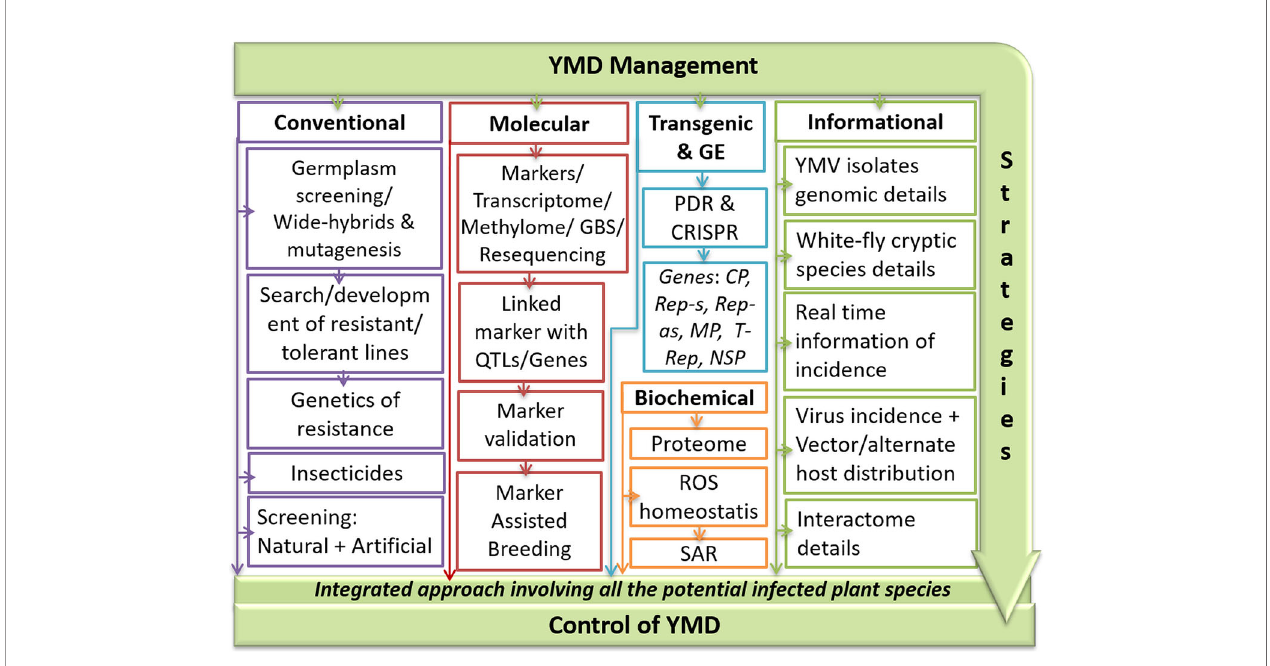
FIGURE 7 | An outline of integrated YMD management strategies in mungbean. Where, CP, coat protein; CRISPR, clustered regularly interspaced short palindromic repeat; GBS, genotype by sequencing; GE, genome editing; MP, movement protein; NSP, nuclear shuttle protein; PDR, pathogen-derived resistance; QTL, quantitative trait loci; Rep, replication protein; ROS, reactive oxygen species; SAR, systemic acquired resistance; YMD, yellow mosaic disease; YMV, yellow mosaic